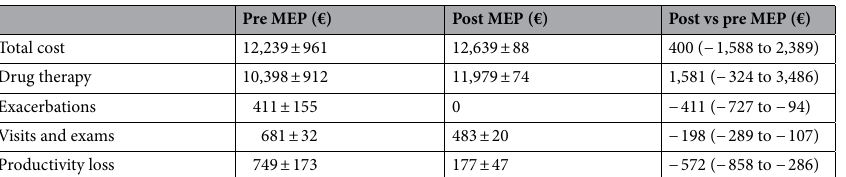
Table 3. Total pre- and post-MEP annual costs. Annual costs are reported as mean ± standard deviation, and annual delta as mean (95% confidence interval). MEP mepolizumab, OMA